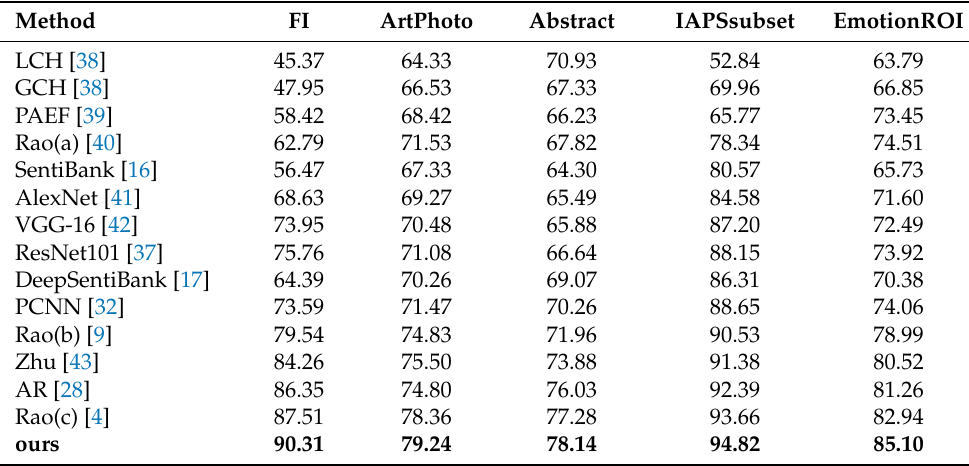
Table 3. Classification results of different state-of-the-art methods on five different datasets: FI,